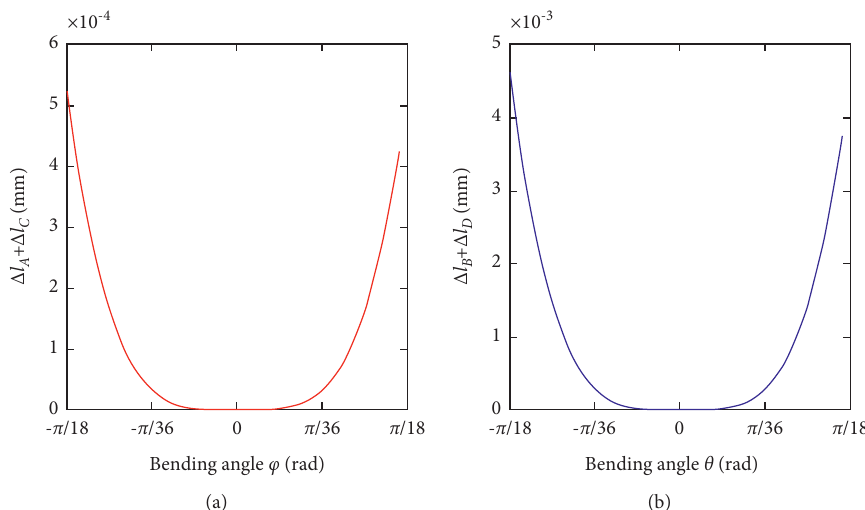
Figure 7: The sum of the antagonistic cables’ length changes in any pair of cables. (a) Bending angle φ (rad). (b) Bending angle θ (rad).